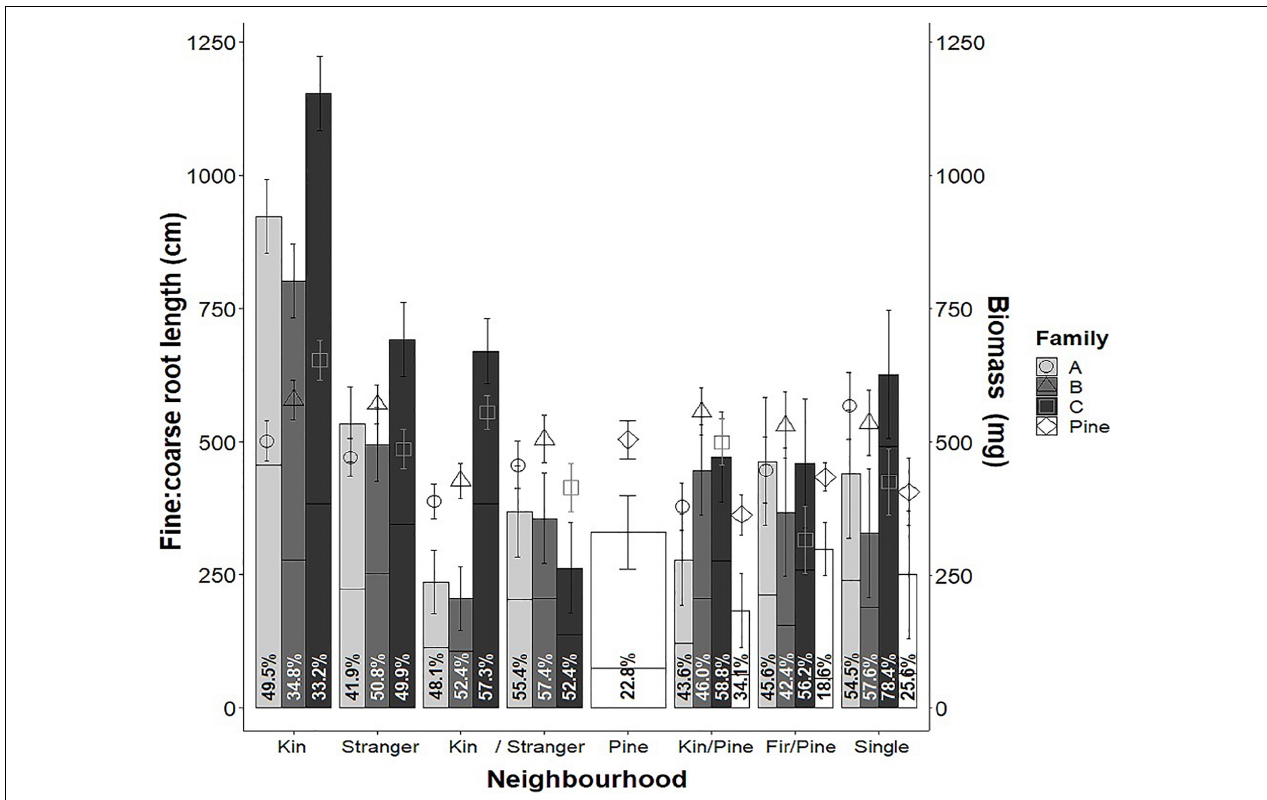
FIGURE 10 | Mean biomass (bars), fine: coarse root allocation (points) and colonization (shown as a percent of biomass in lines and percentages in text) of families A, B, and C of greenhouse-grown interior Douglas-fir (Fdi) and lodgepole pine (Pine) in all neighborhood treatments as well as single seedlings grown in plots with no immediate neighbors. Estimated marginal means are from a linear model of y ∼ Family × Relation × Treatment ( y = biomass and colonization) and fine root length ∼ coarse root length + Family × Stand × Relation. Error bars shown as estimated marginal means ± one standard